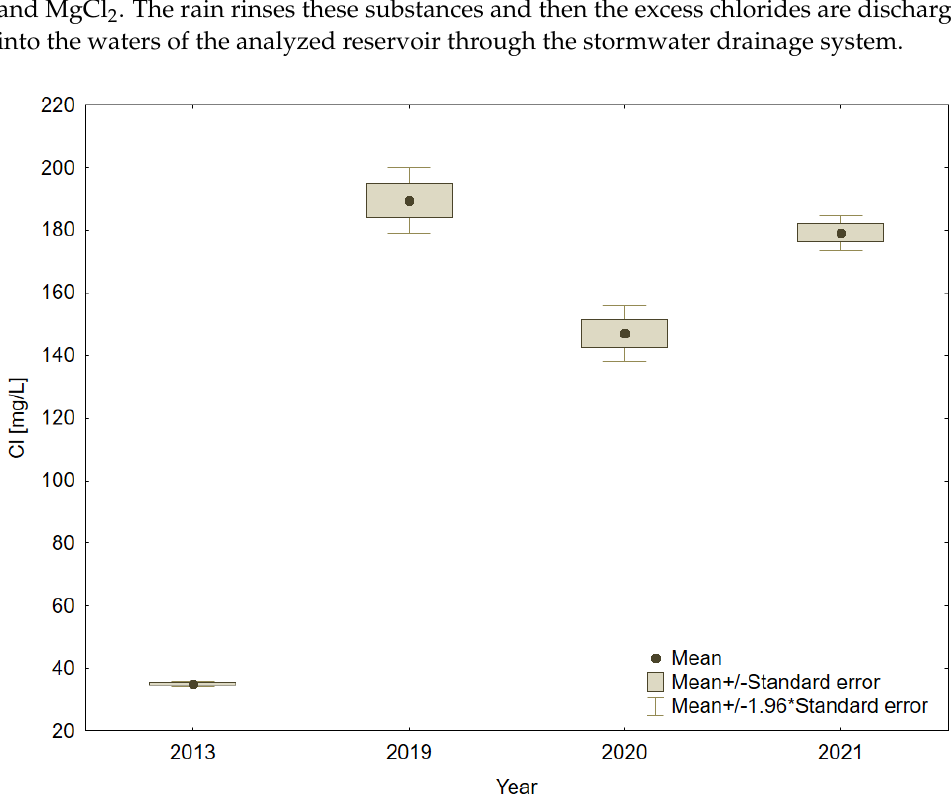
Figure 5. Average annual values of Cl content in the water of Mielenko Lake. The iron content in the waters of Lake Mielenko varied in the range from 0.13 to 0.78 mg Fe/L. In the last research years, clearly higher concentrations occurred in summer, in July. Before changes of the use of the catchment area (2013), the mean quantity of iron in the water of the lake was 0.455 ± 0.032 mg Fe/L (Figure 6). In 2021, the mean values of Fe decreased to c.a. 0.240 ± 0.120 mg